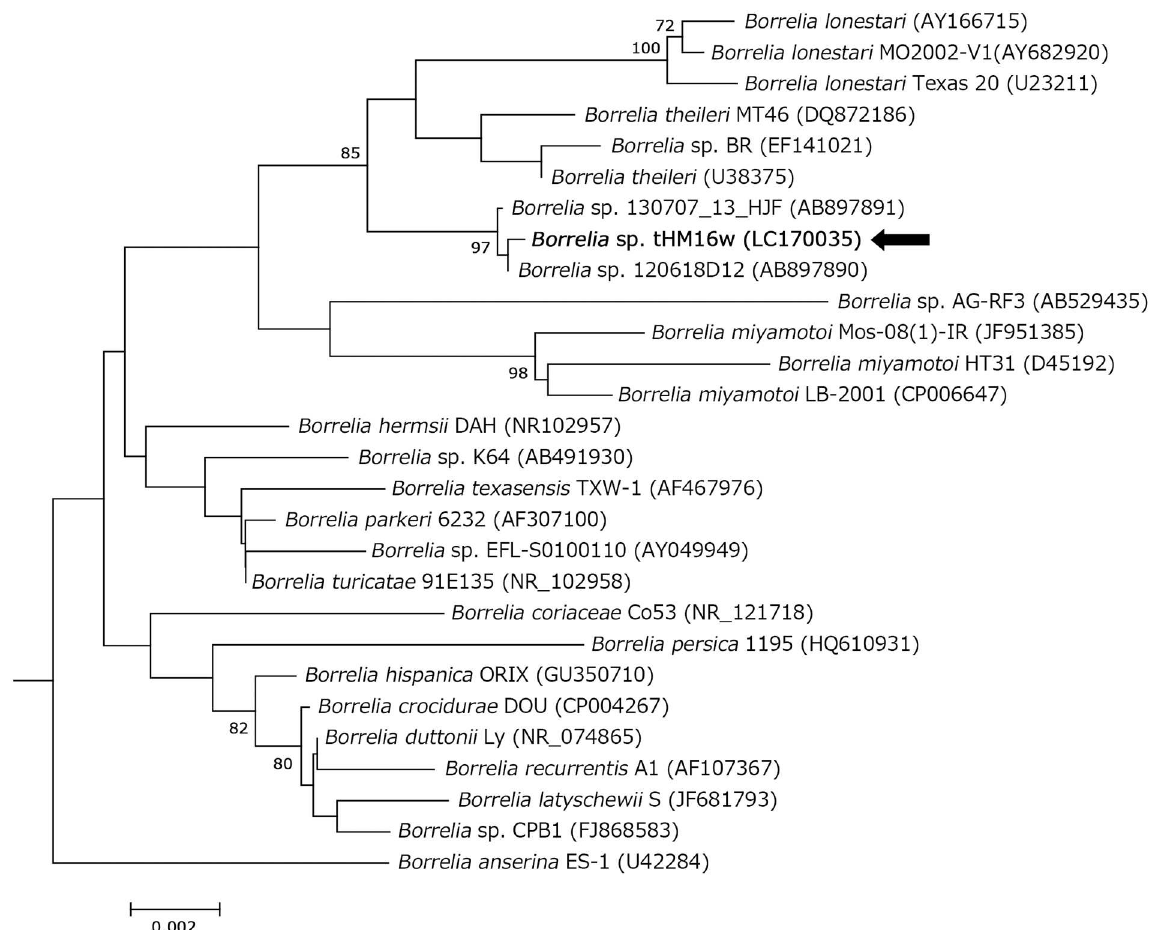
Fig 4. Phylogenetic analysis of 16S rDNA in Borrelia spp. The tree was constructed using the neighbor-joiningmethod basedon the Kimura two-parameter model. The phylogenetic brancheswere supported by > 70% accordingto the bootstrap analysis. The bar indicatesthe percentage of sequencedivergence. B . afzelii PKo (accession no. NR_074840), B . garinii PBi (CP000013),and B . burgdorferi B31 (U03396) were used as outgroups(data not indicated).Pointingarrows and bold type indicate the results obtainedin the present study. Numbers in parentheses represent GenBank